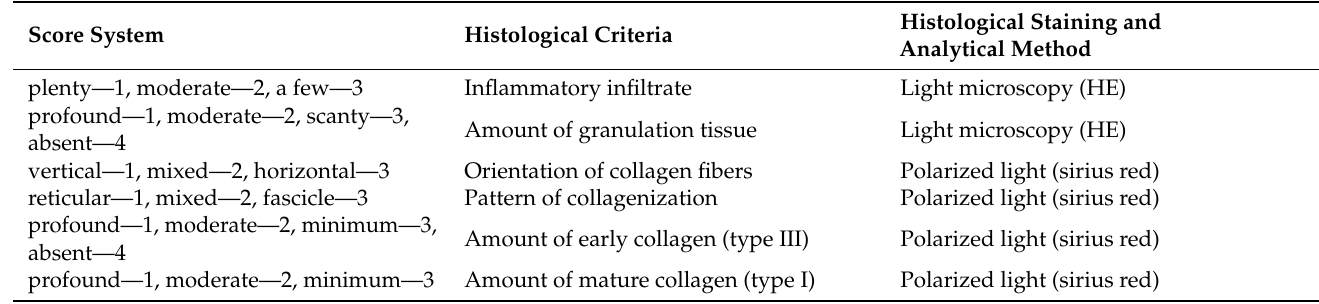
Table 1. Parameters assessed to calculate wound healing